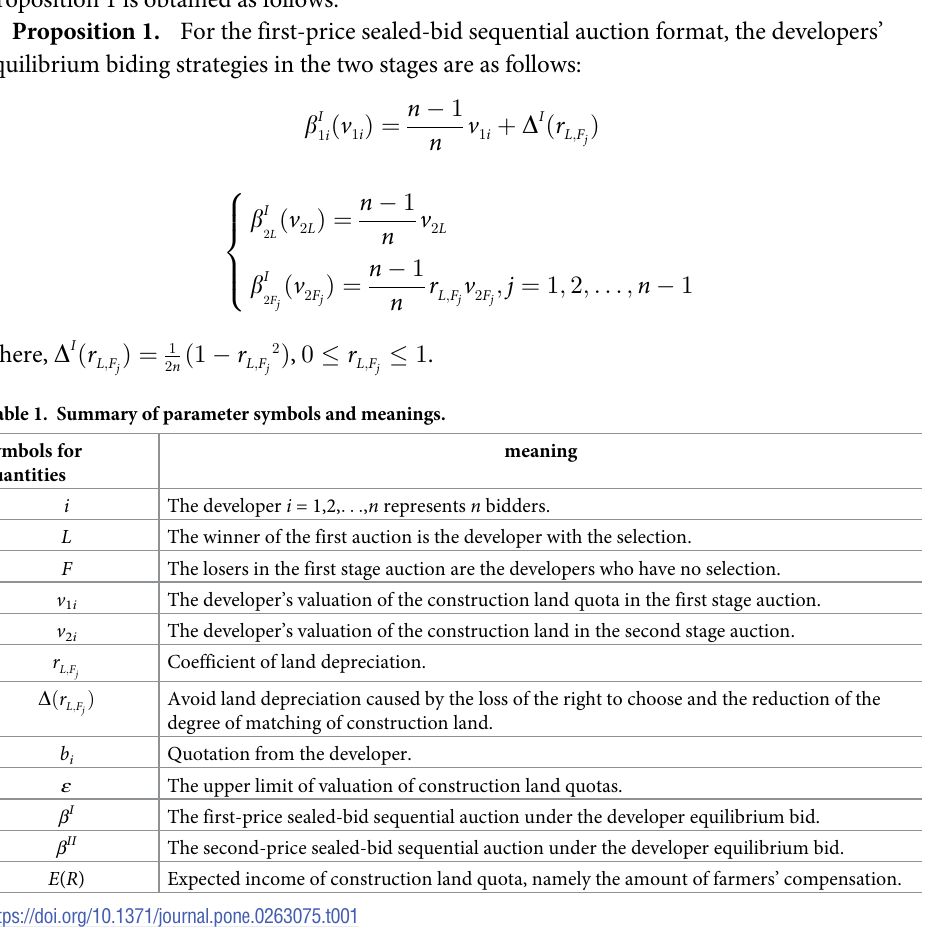
Table 1 summarizes the parameter symbols and meanings involved in this model.